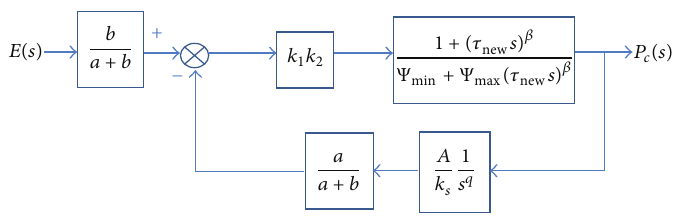
Figure 3: Block diagram for the fractional order